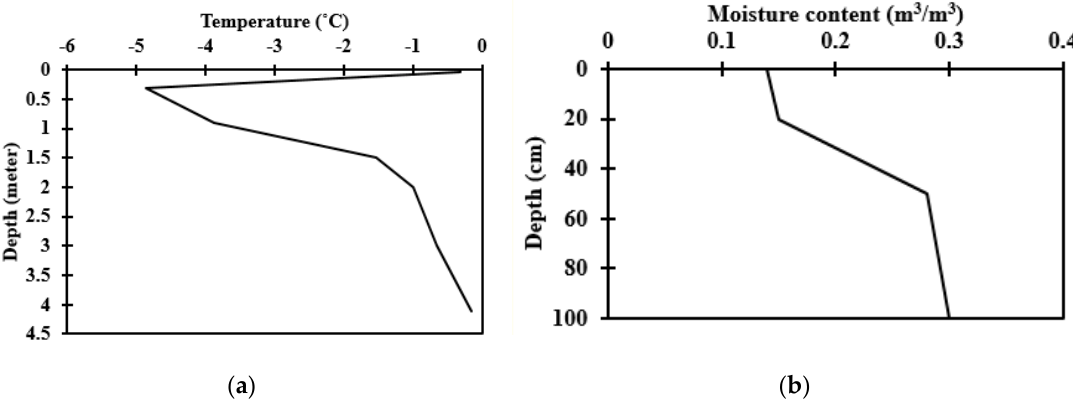
Figure 5. Initial conditions: ( a ) Initial soil temperature profile for the thermodynamic numerical simulation and ( b ) Initial soil moisture content profile for the unsaturated zone numerical simulation.